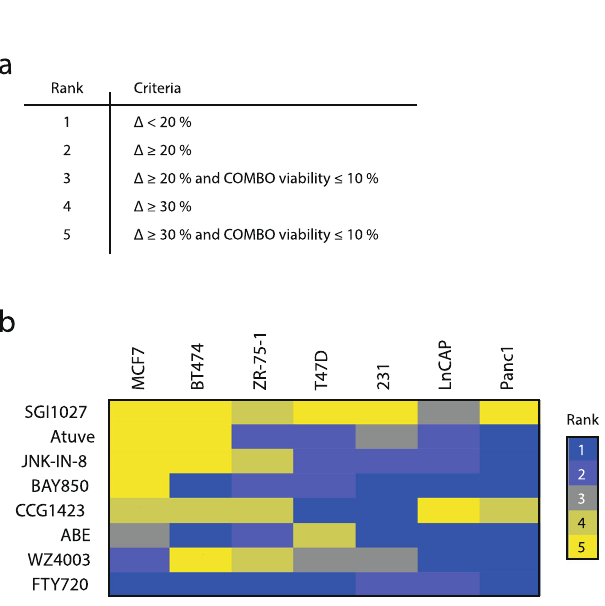
Fig. 3 Validation of potential targets by siRNA gene perturbation and drug combination in MCF-7 cells. a Set of eight hits for which small-molecule inhibitors are commercially available were evaluated individually by siRNA gene perturbation. b Five genes without available small-molecule inhibitors were individually validated by siRNA gene perturbation :NDNF, NOSIP, and PDAP1 are genes that appeared in more than one group of the four 25 gene groups that comprise the top 100 dropout candidates (Supplementary Data 1, Supplementary 1 Tables). OR5I1 and OR4D6 belong to a large multigene family of olfactory receptors that are evolving as potential targets in cancer therapy. c For Rhoa, Jun, CCNT1, NDNF, OR4D6, CDK4, MAPK8 genes a second round of siRNA perturbation experiments was performed with lower concentrations of SI-12. In all the siRNA perturbation experiments the cells were treated with 10 nM of the indicated target siRNA or negative control siRNA (NC) for 48 h, plated in 96 well plates, and exposed to SI-12 treatment for 96 h. At the end of the SI-12 treatment period, the cells were subjected to MTS viability assay. d In vitro drug combination experiments. Small molecule inhibitors that target the screen hits were tested in combination with SI-12. Cells were plated in 96 well plates and treated with the indicated compound(s) for 96 h. At the end of the drug treatment period, the cells were subjected to an MTS viability assay. For drug concentrations see Table 1. Each point re fl ects at least four technical replicates. Each cell viability plot represents at least two independent experiments showing similar results. Statistical signi fi cance compares between the combo and the most effective single agent (either SI-12 at relevant concentration, or the partner molecule). ***For all the results P < 0.01, two-tailed Student ’ s t -test, if not mentioned otherwise. n.s ., not signi fi cant.